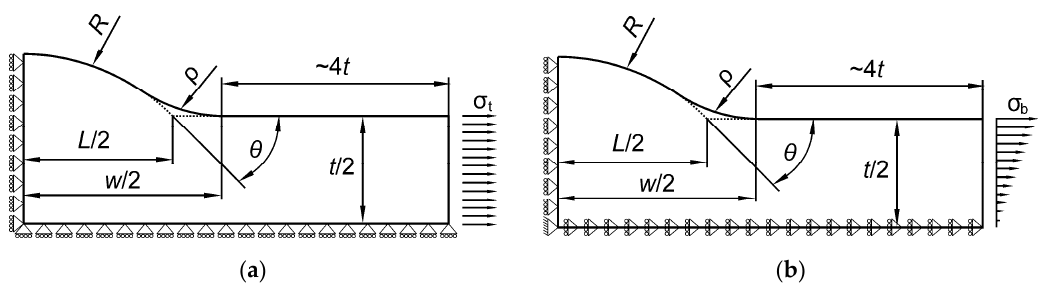
Figure 2. Boundary conditions for a Double–V butt-welded joint subjected to ( a ) tensile and ( b ) bending loads.